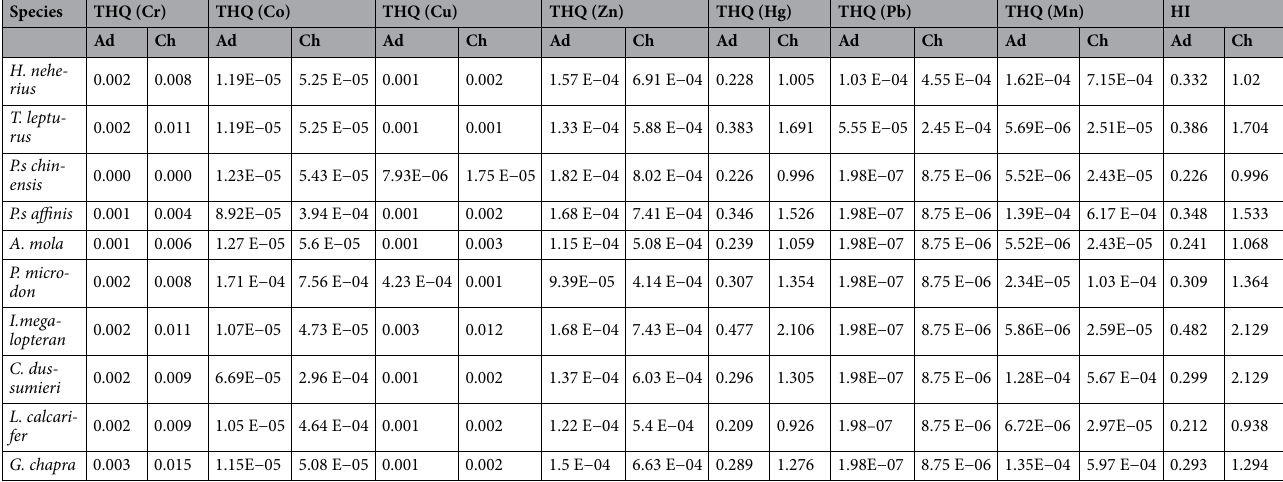
Table 7. Calculated THQ and HI for two selected age groups, adults (Ad) and children (Ch).